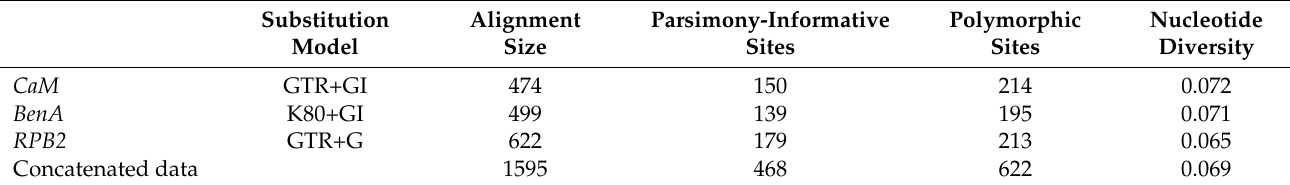
Table 1. Descriptive parameters of datasets and nucleotide substitution